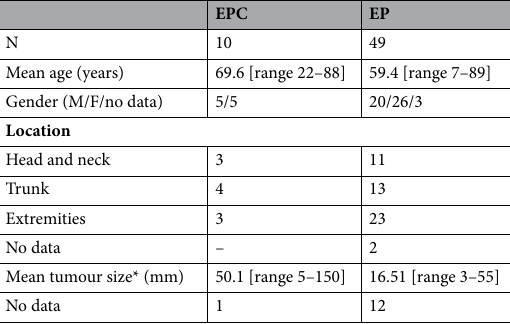
Table 2. Summary of patient and tumour data. *Longest diameter of the tumour.